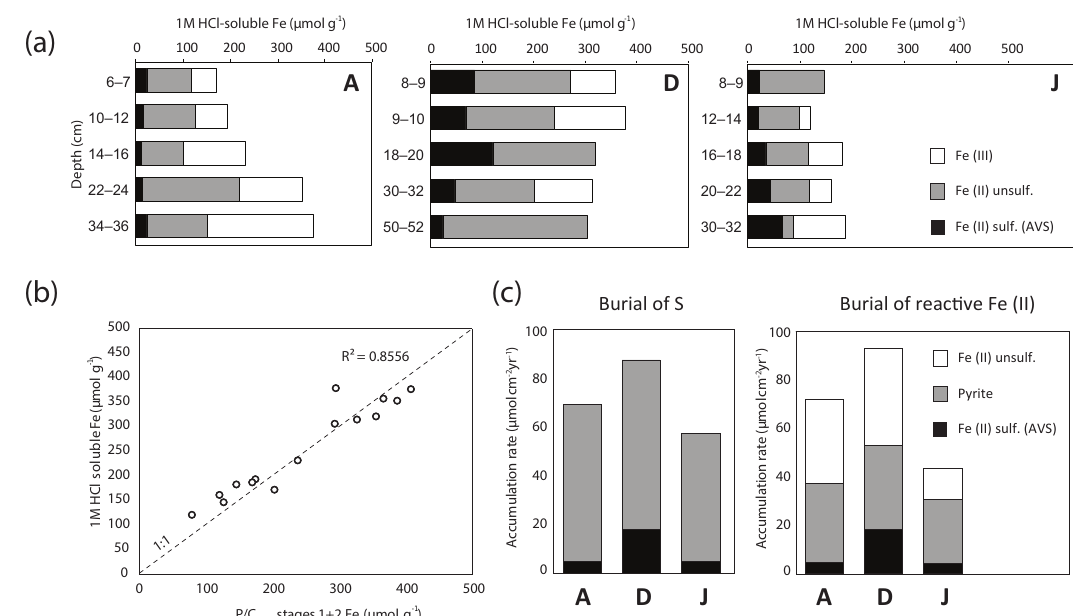
Figure 6. (a) Results of the 1M HCl extraction, carried out on 15 samples (five each from Stations A, D, J). (b) Comparison of total 1M HCl- soluble Fe and the sum of Stages 1 + 2-soluble Fe in the Poulton and Canfield (2005) protocol. Where no equivalent sample was available, adjacent samples have been compared ( n = 4). Dashed line represents 1 : 1 and the least-squares regression is performed against this